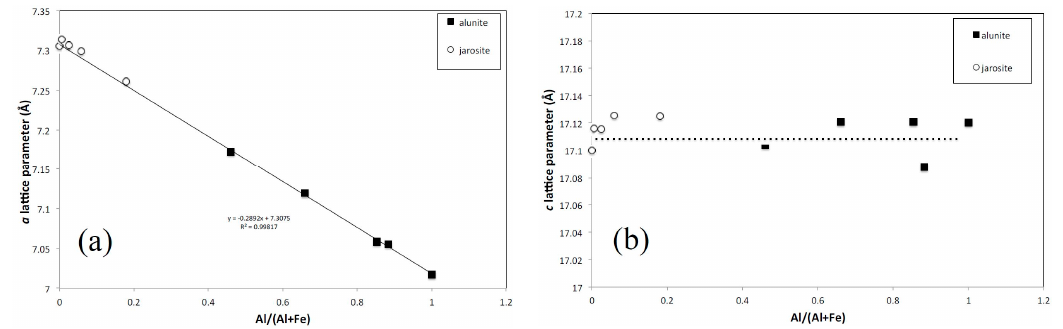
Figure 7. Lattice parameters ( a ) a and ( b ) c obtained from Rietveld analysis for alunite and jarosite versus Al content in solid.